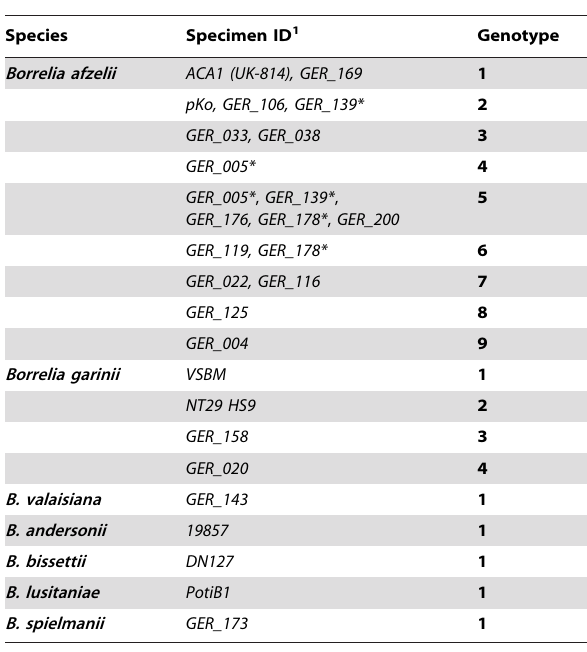
Table 4. Other Borrelia species genotypes. Table 5. Comparision of ospC typing vs. PCR/ESI-MS